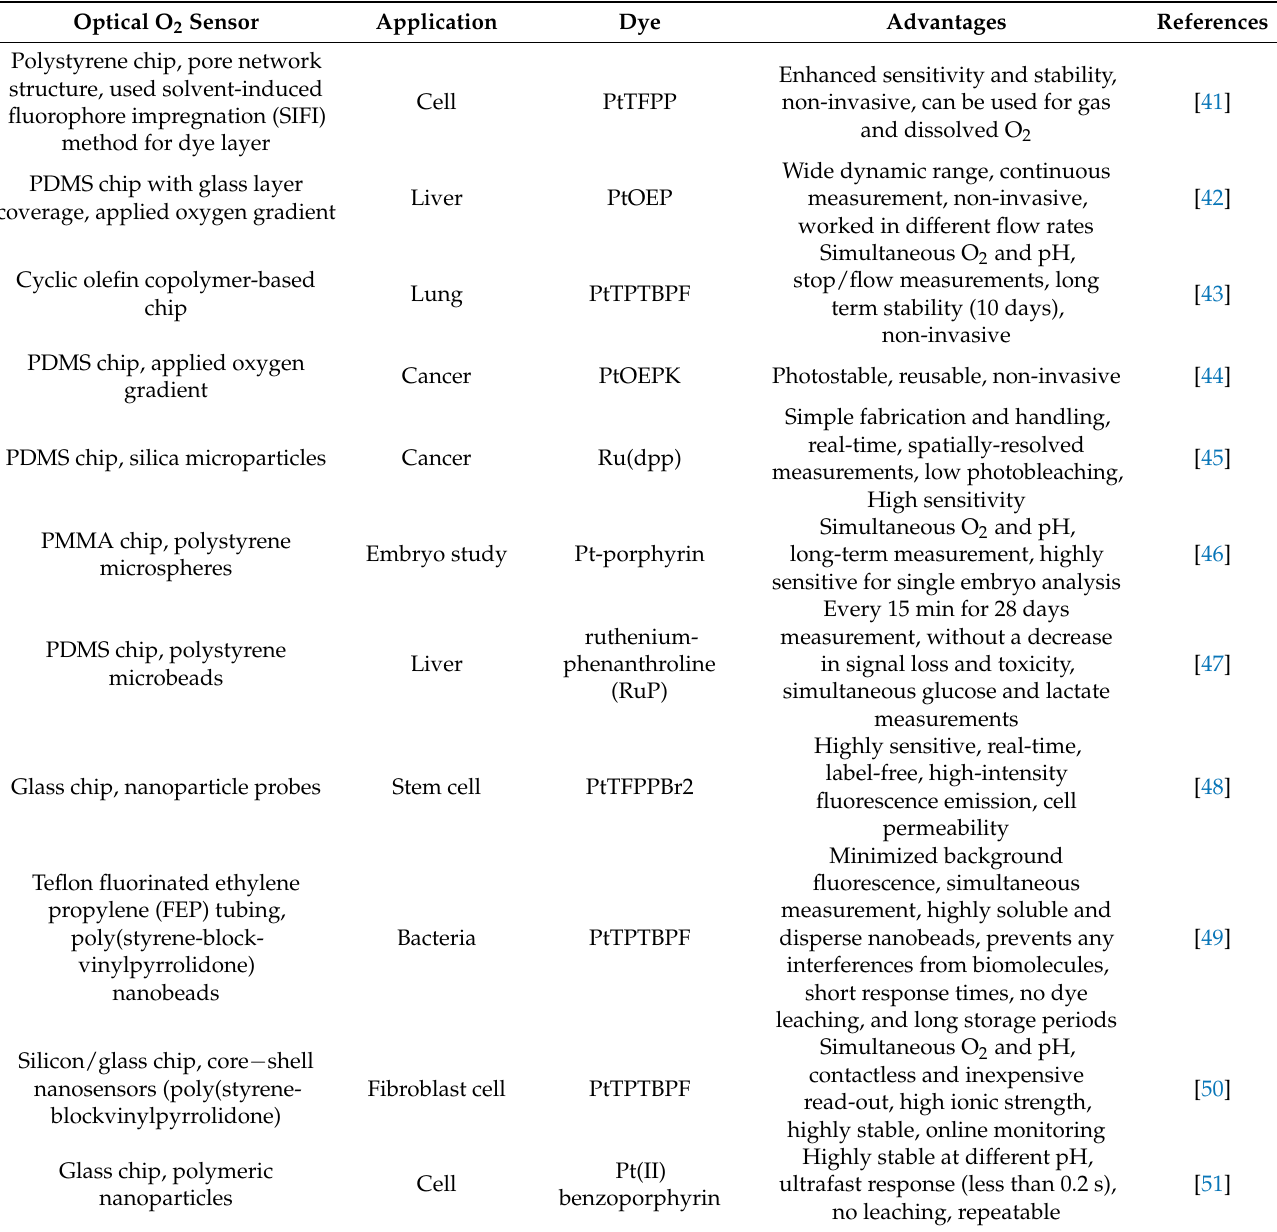
Table 2. Characteristics of chip-based optical O 2